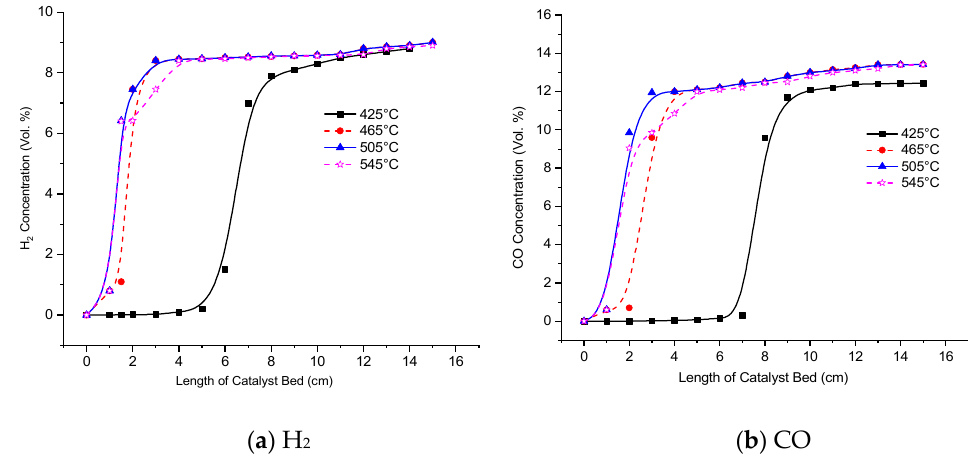
Figure 3. Reaction temperature effect on H 2 and CO concentration.